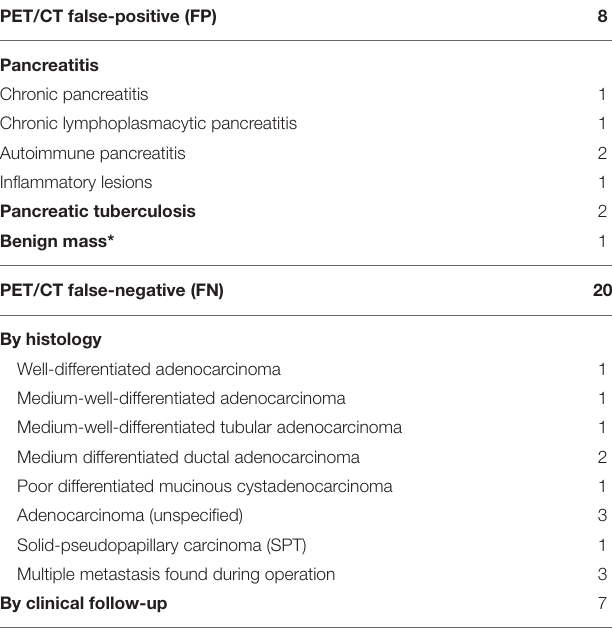
TABLE 2 | Histology results of 142 patients. TABLE 3 | Misdiagnosed cases of